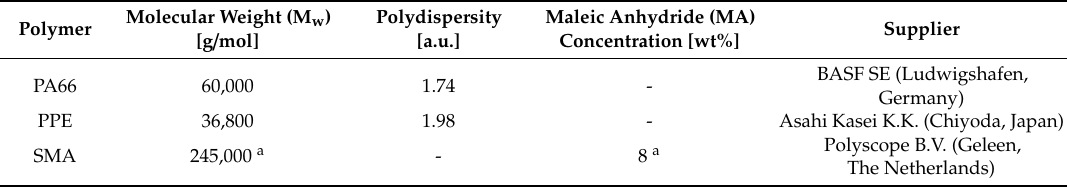
Table 1. Properties of blend